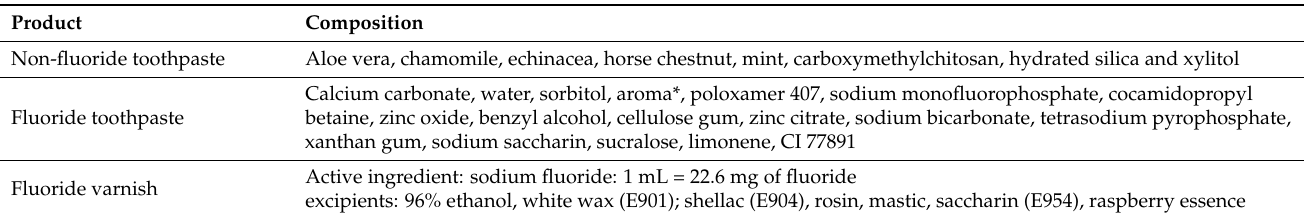
Table 2. The composition of the products used for the